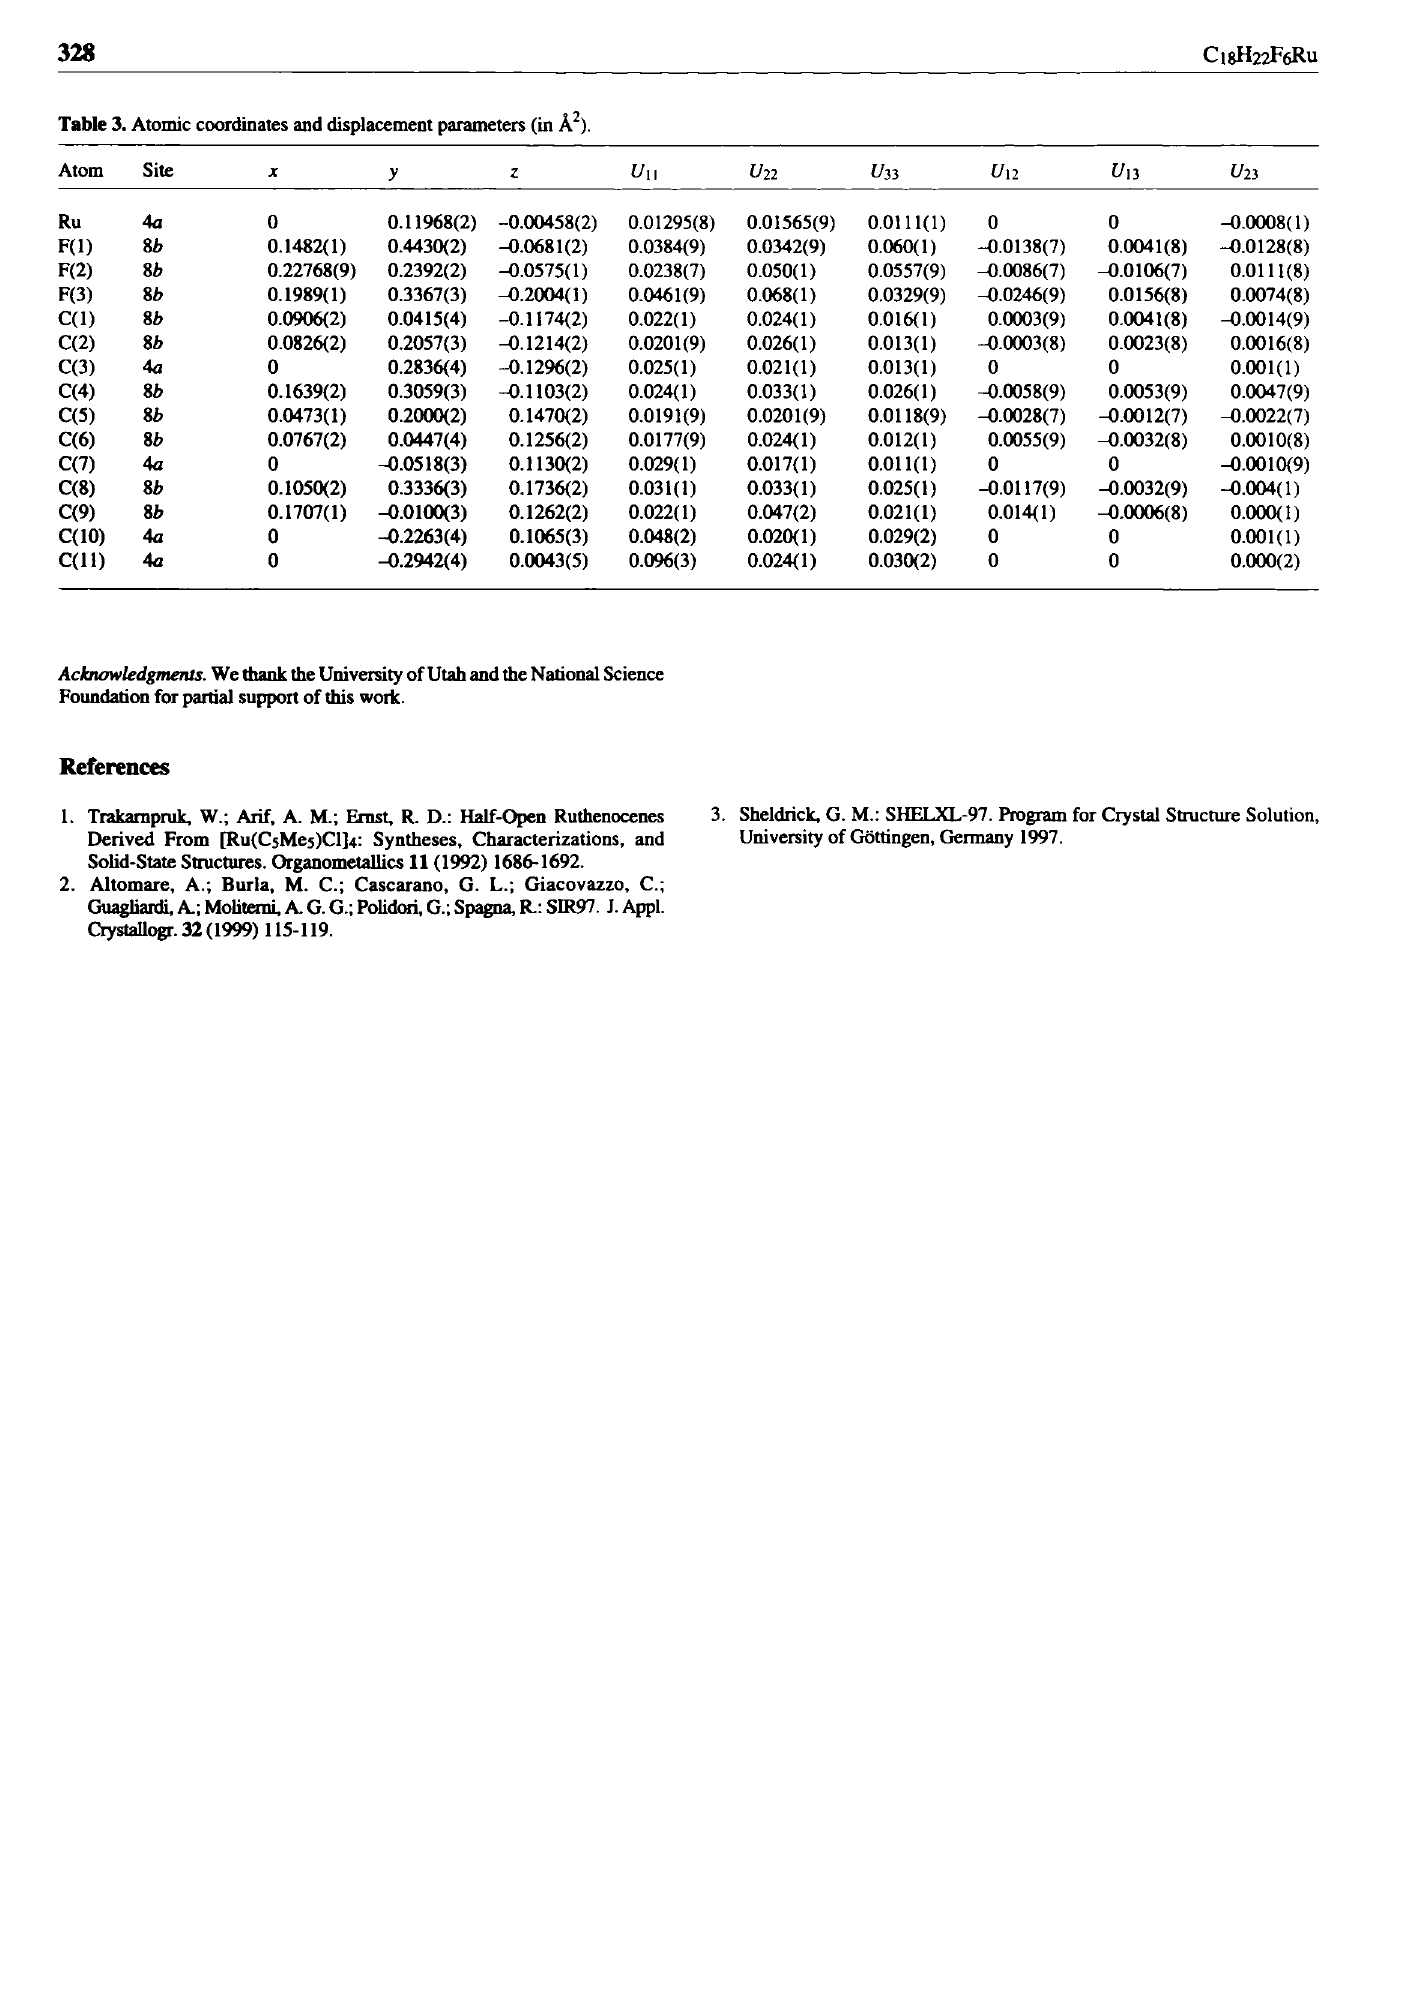
Table 3. Atomic coordinates and displacement parameters (in Â 2